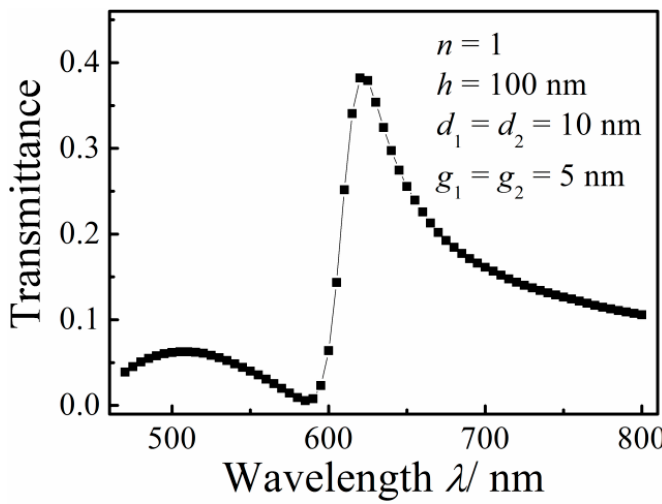
Figure 2. Transmission spectrum of the MIM waveguide-coupled double rectangular cavities.